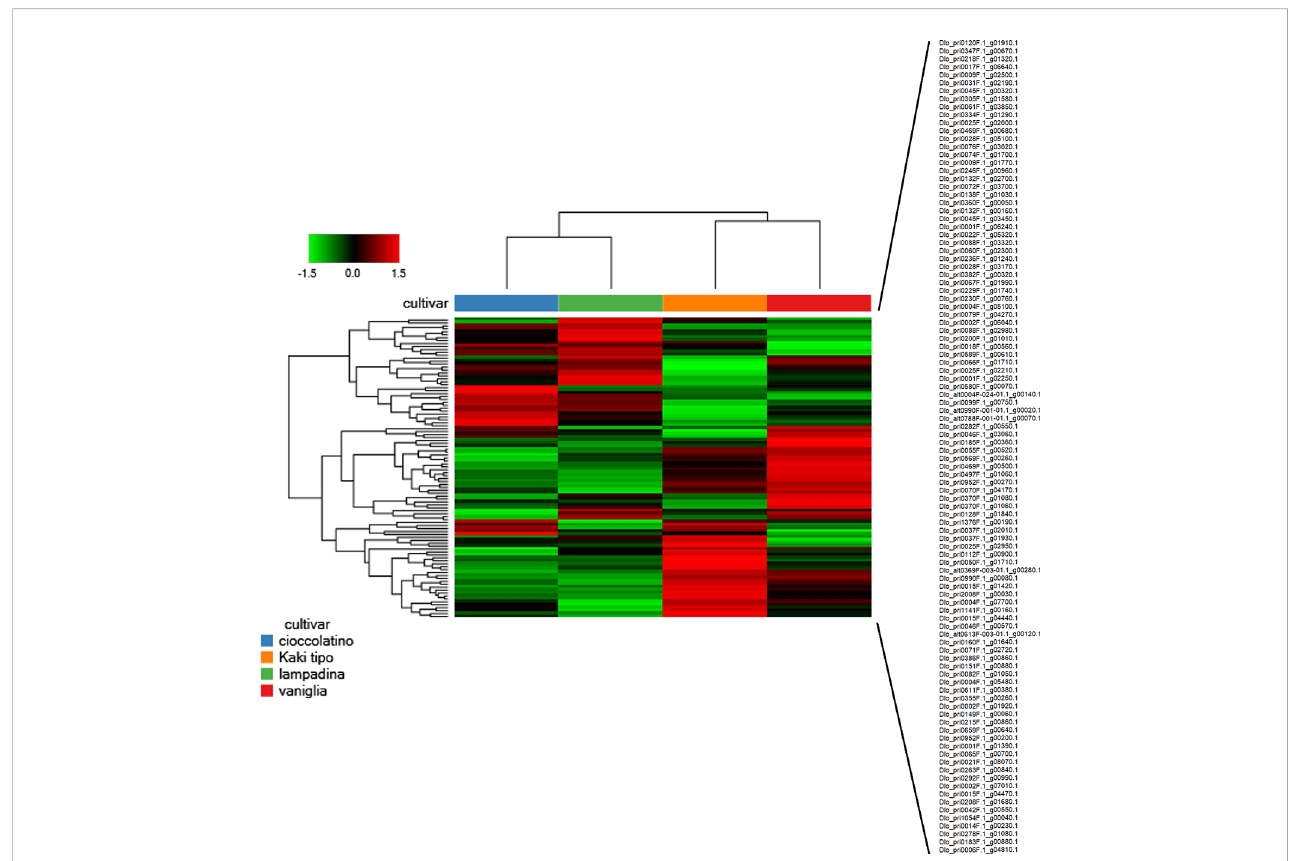
FIGURE 2 Heat-map showing the variable abundance of differentially represented proteins in persimmon fruits of Kaki tipo, Cioccolatino, Vaniglia and Lampadina cultivars. Each column corresponds to a cultivar, whereas each row represents a single protein. Increasing brightness towards red indicates higher protein responses (measured as summed peak areas) and green indicates lower protein responses. Protein abundance values were grouped for three replicates and scaled before clustering. The dendrograms from the unsupervised hierarchical cluster analysis of the columns and the rows (using the Euclidean distance function and average linkage method) illustrate the similarity of the cultivars and proteins. Protein accession codes reported on the right side of the fi gure (102 in number) are vertically ordered according to fi gure appearance. Detailed information on differentially represented proteins reported in this fi gure are described in Supplementary Table